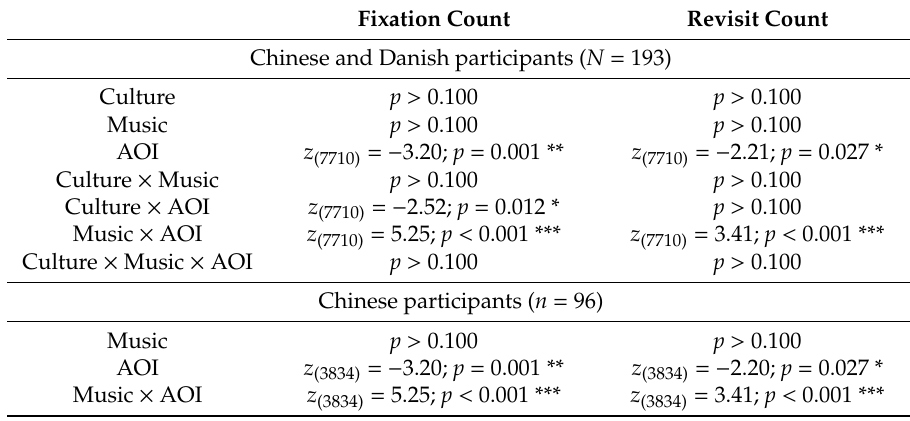
Table 1. Summary of significant eye-tracking results of the fixed effects in the omnibus generalized table includes the three-way model with both cultures. Below is each separate model for Chinese and Danish participants, respectively, which were focused on in the subsequent analyses.